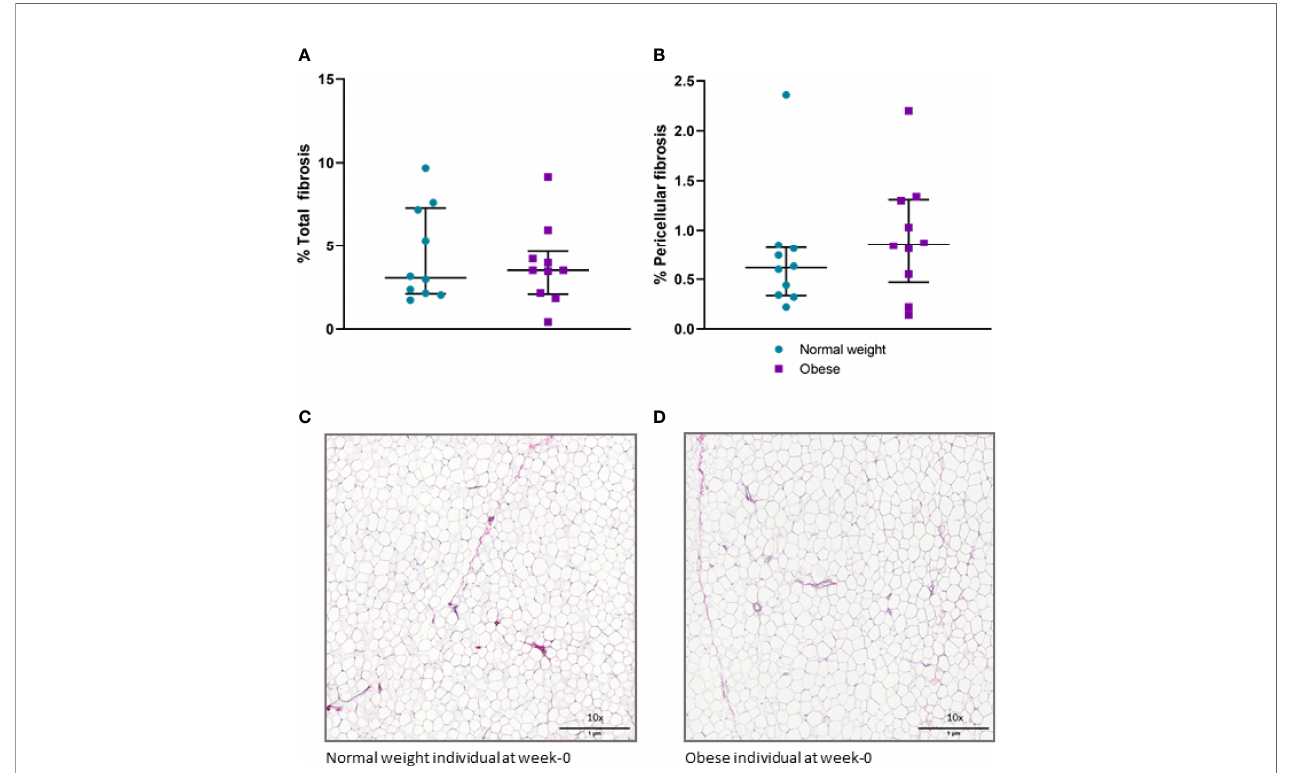
FIGURE 6 | (A) Percentage of total fi brosis in scWAT in normal weight and individuals living with obesity at week-0; (B) Percentage of pericellular fi brosis in scWAT in normal weight and individuals living with obesity at week-0; (C) Picro Sirius red stained collagen in a section of scWAT at 10 x magni fi cation from a normal weight individual at week-0; (D) Picro Sirius red stained collagen in a section of scWAT at 10 x magni fi cation from an individual living with obesity at